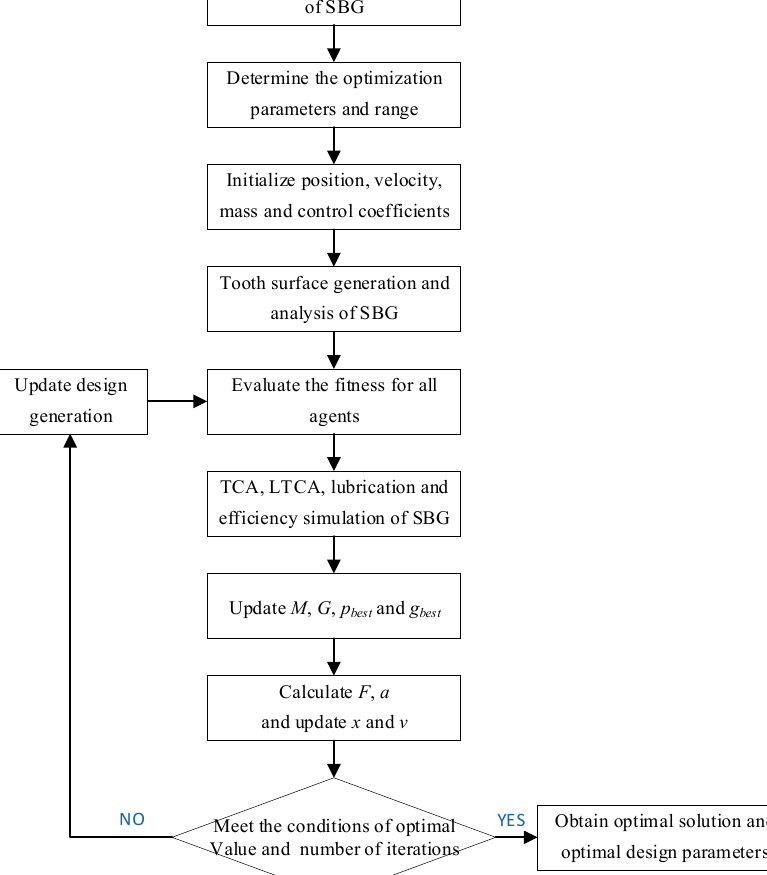
Figure 3. Flow chart for SBG efficiency optimization based on hybrid PSOGSA algorithm.